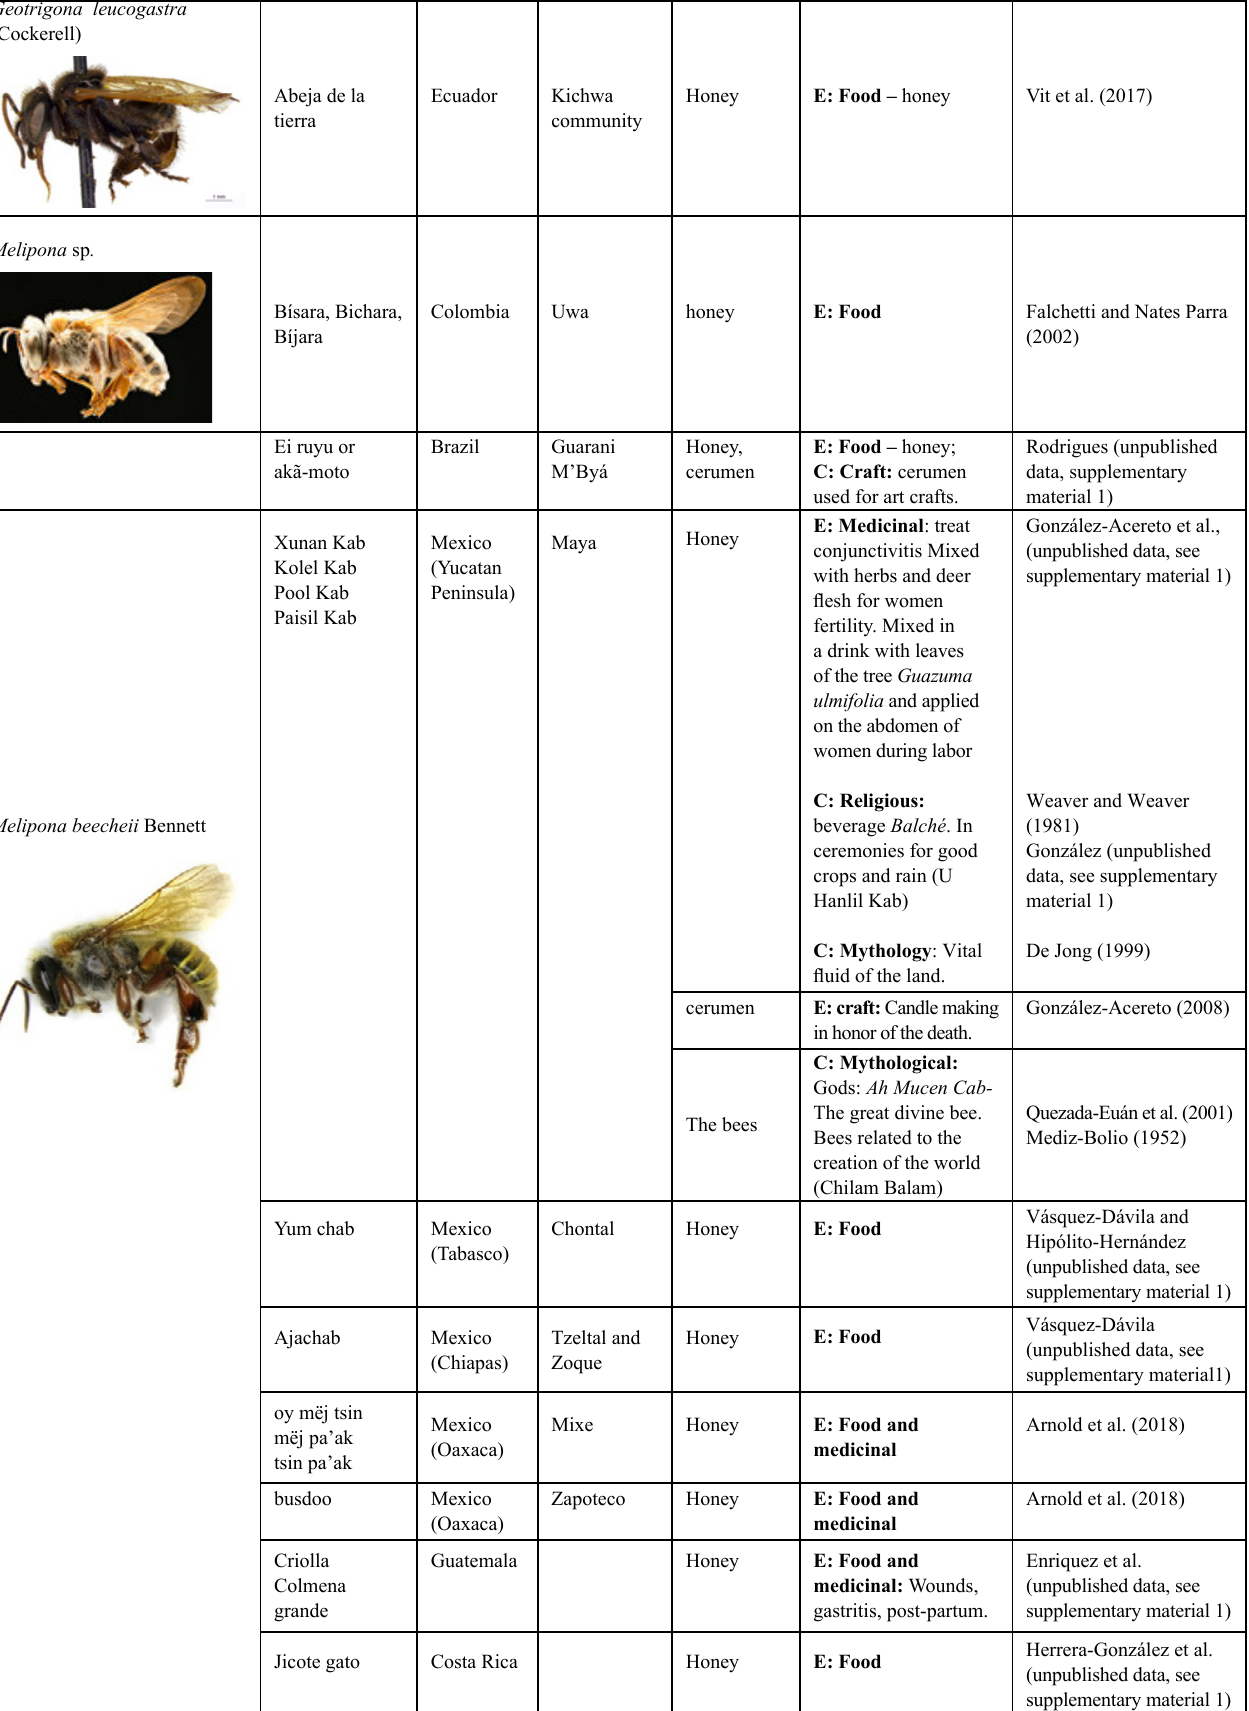
Table 1 . Economic and cultural values associated with stingless bees by different ethnic groups of tropical America. Geotrigona leucogastra (Cockerell) Ecuador Honey E: Food – honey Vit et al. (2017)